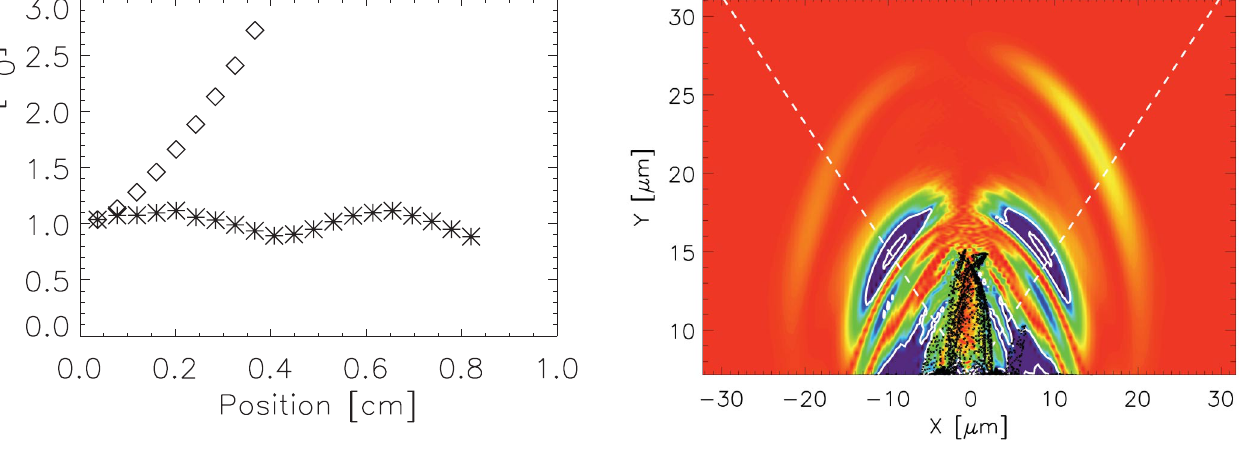
foil.FIG. 7. Laser pulse width for propagation in a channel (stars) and without a channel